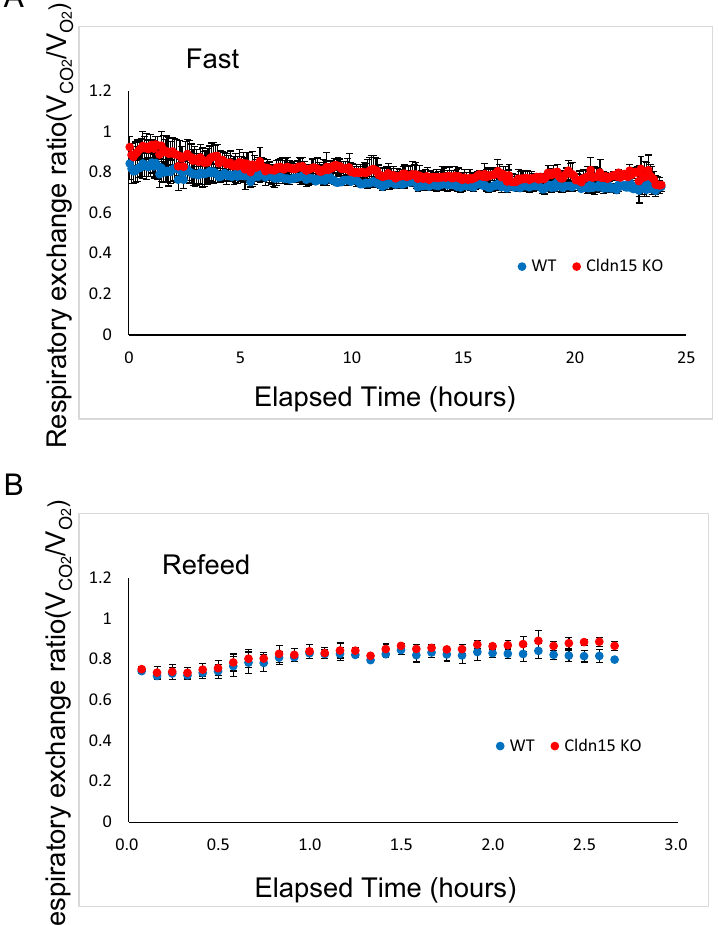
Figure 3. Energy metabolism in claudin-15 knockout and WT mice. Cldn15 KO (n = 3) and WT (n = 3) mice were placed into metabolic cages and after a period of adjustment, the resting quotient (RQ) was measured by indirect calorimetry for ( A ) fasting and ( B ) re-feeding. Data are expressed as the mean for each time point and the error bars are the